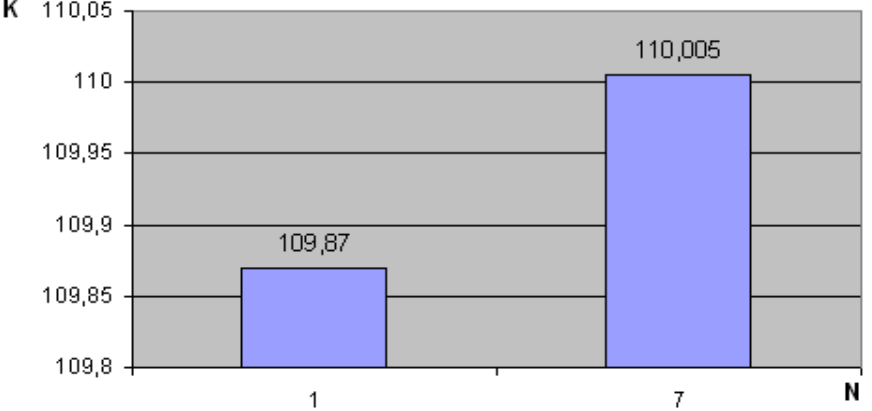
Fig. 4. Comparison of the control group data at the beginning and at the end of the experiment, K – number of meters passing by the control group students in 12 minutes (Y